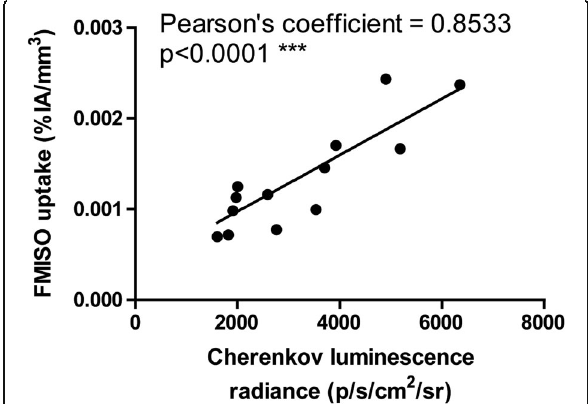
Fig. 1 Correlation between Cherenkov luminescence imaging and PET following the injection of FMISO ( n = 13, Pearson ’ s coefficient = 0.8533, p < 0.0001***). Results are presented as radiance (p/s/cm 2 /sr) for CLI and %IA/mm 3 for